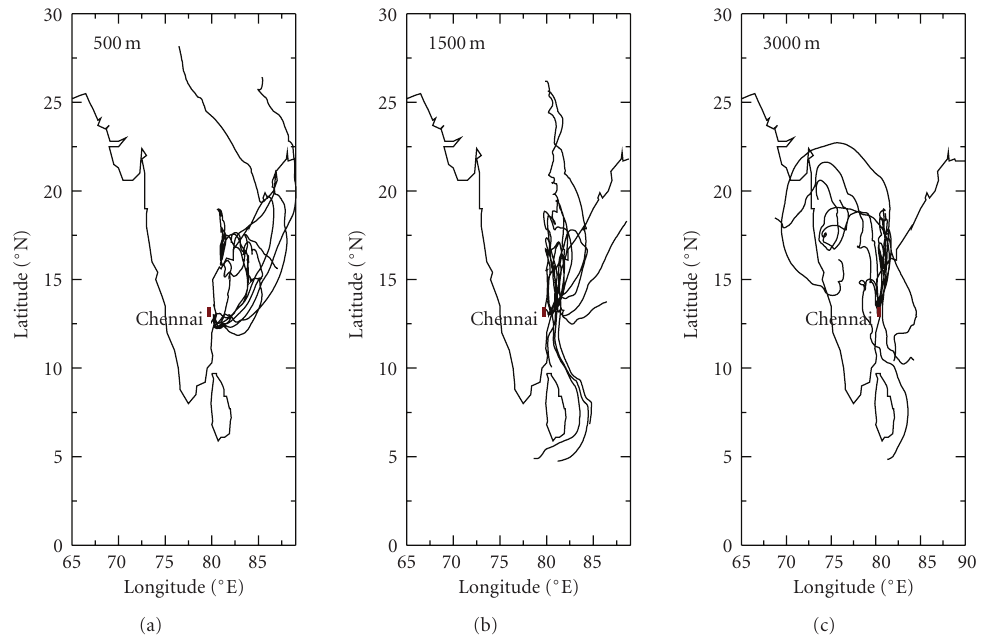
Figure 2: Airmass back trajectories arriving o ff Chennai coast at three di ff erent heights, 500, 1500, and 3000 mamsl, respectively.